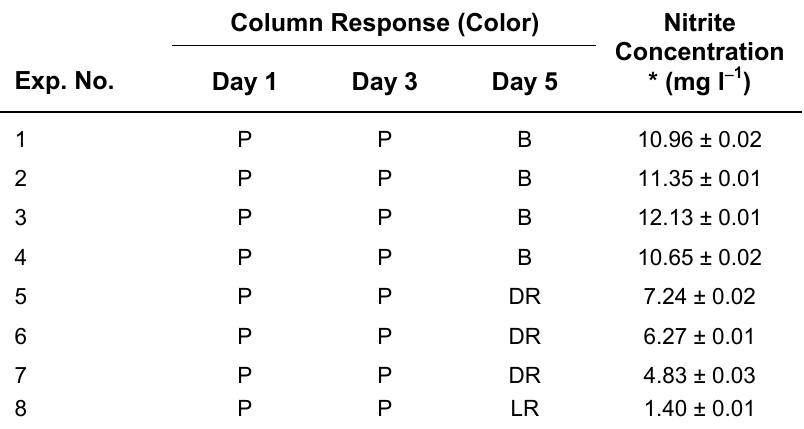
Results from Spot Tests and Nitrite Production on Initial Responses of AOB to Enrichment Medium Column Response (Color)